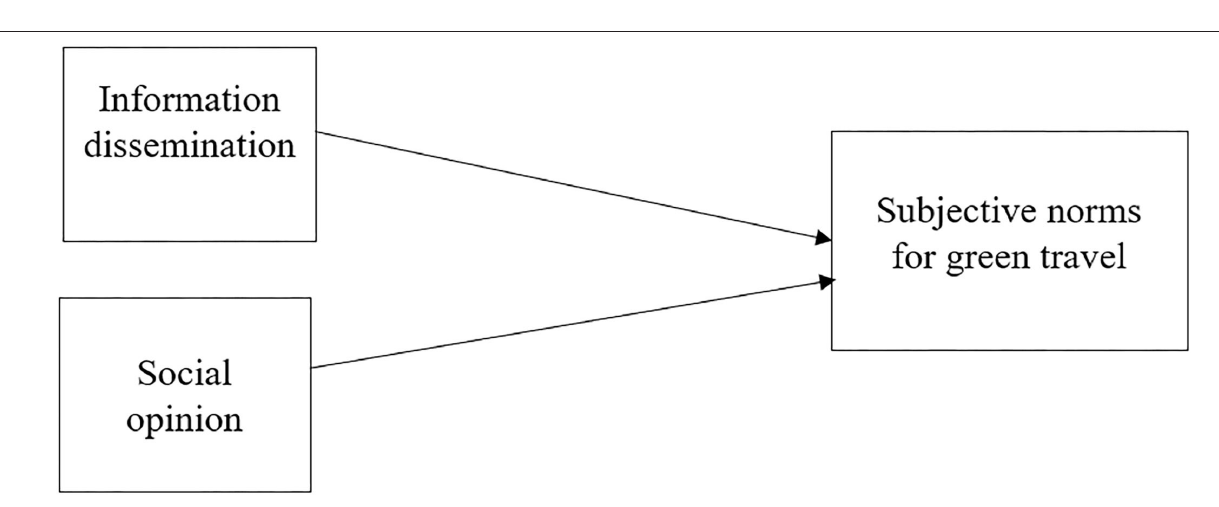
H1c: Social propaganda policies have a significant positive influence on public perceived behavior control of green